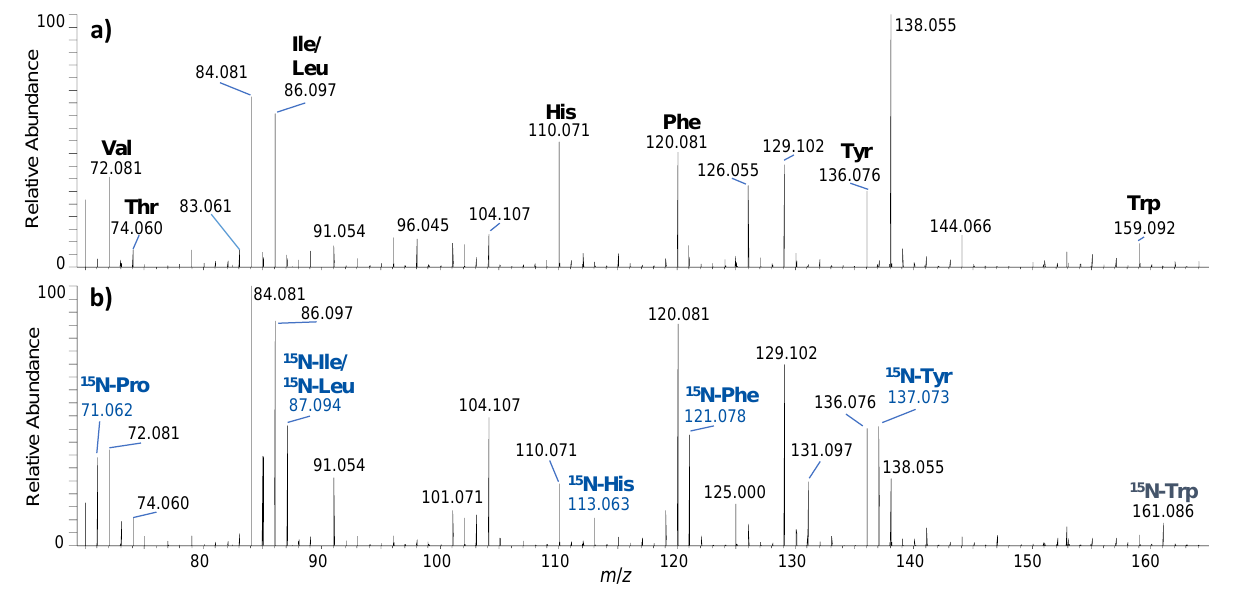
Figure 2. All-ion fragmentation mass spectra depicting the ( a ) non-labelled (“native”) and ( b ) 15 N- labelled immonium ions generated by collision-induced dissociation of hGH ( a )) and 15 N-hGH ( b )) at the respective retention time.